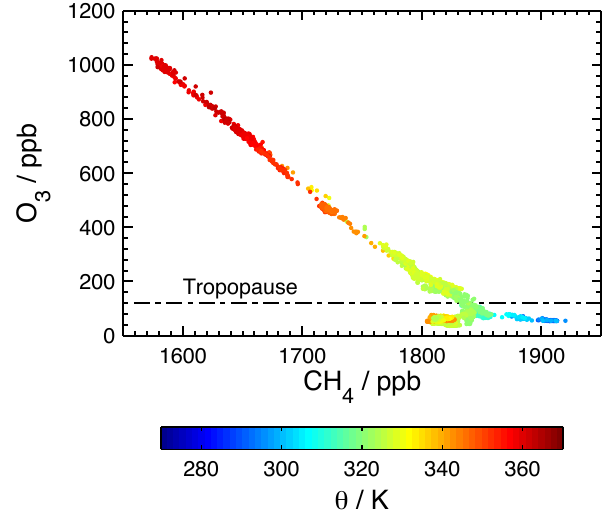
Fig. 12. CH 4 –O 3 correlation on a flight from Bangkok to Frankfurt on 21 March 2013 (colour code: potential temperature θ